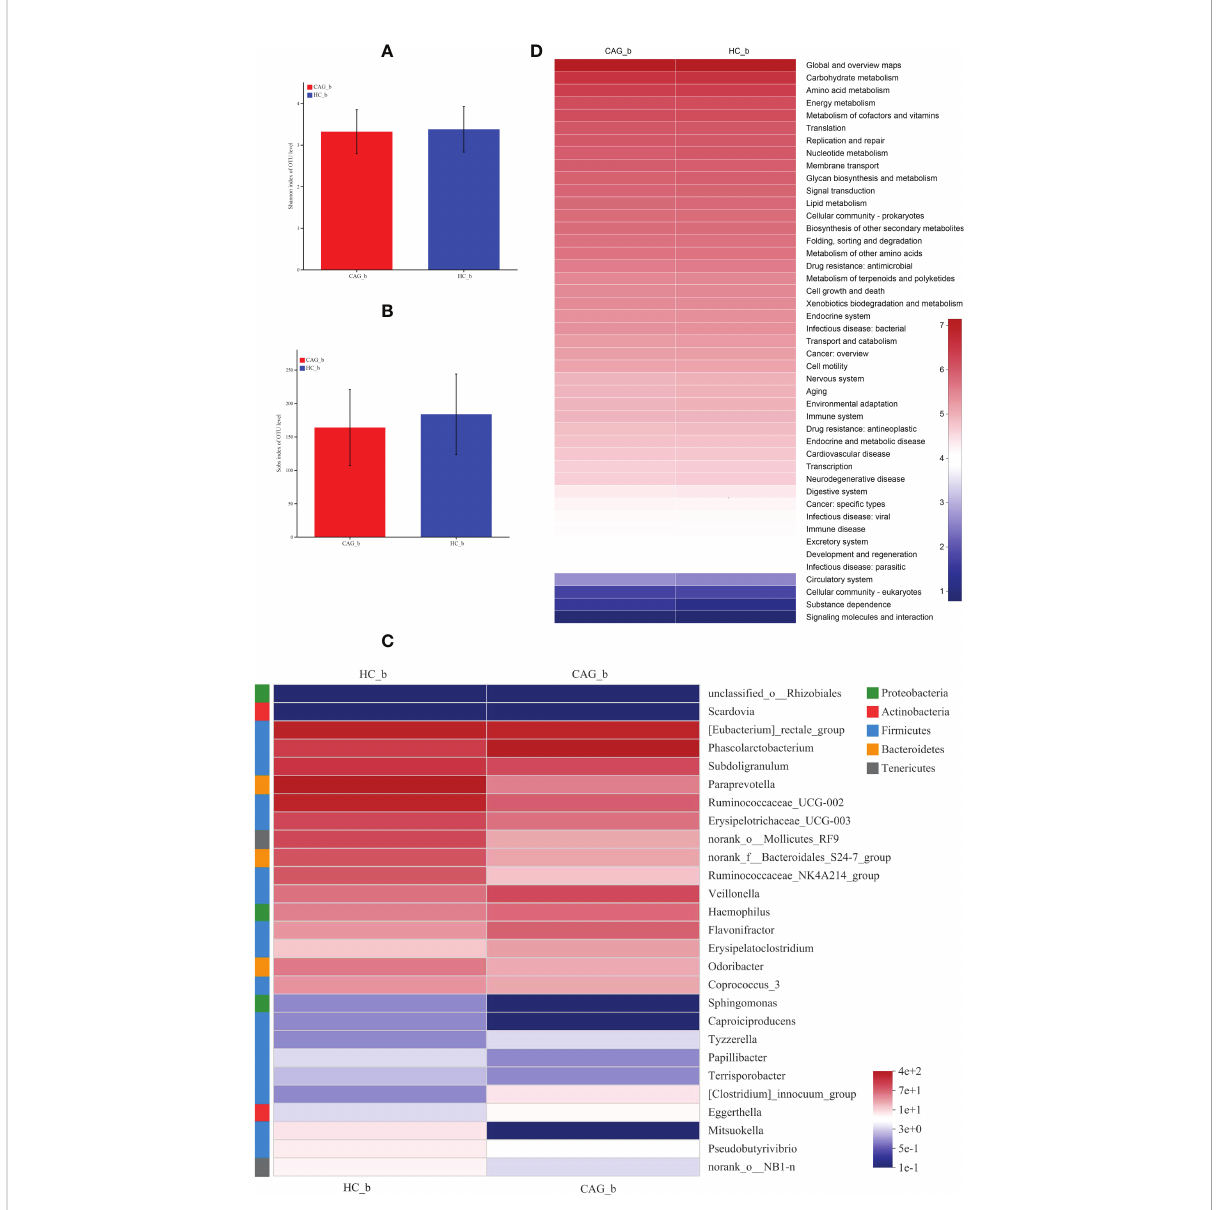
FIGURE 4 Alteration of fecal-derived gut microbiota pro fi les in CAG_b patients. (A) Shannon index of OTU level indicated there is no difference of a - diversity of gut microbiota in feces of CAG patients, compared with HC_b healthy volunteers. (B) Sobs index of OTU level indicated there is no difference of a -diversity of gut microbiota in feces of CAG patients, compared with HC_b healthy volunteers. (C) Alteration of fecal-derived gut microbiota pro fi les in CAG_b patients. (D) KEGG analysis indicated the pathways mediated by the differentiated fecal